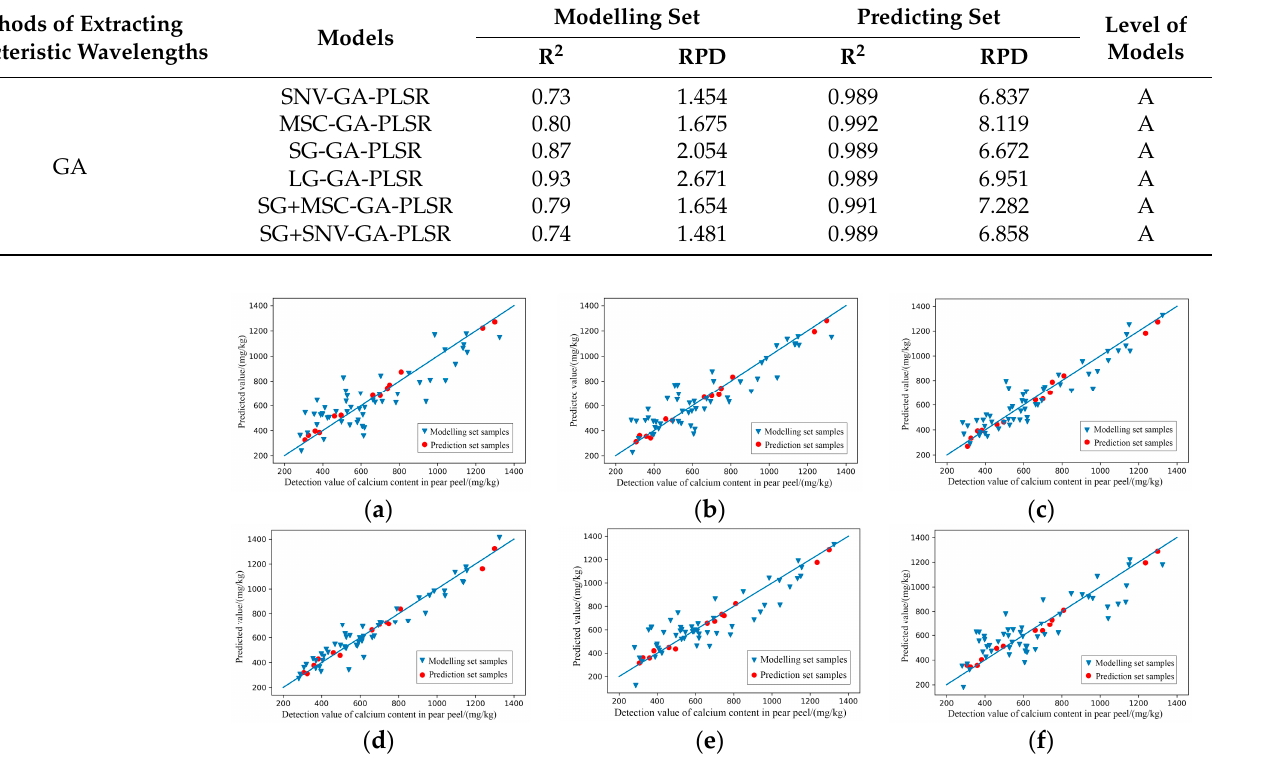
Figure 13. Scatter plots of models’ prediction results of the content of calcium in pear peel